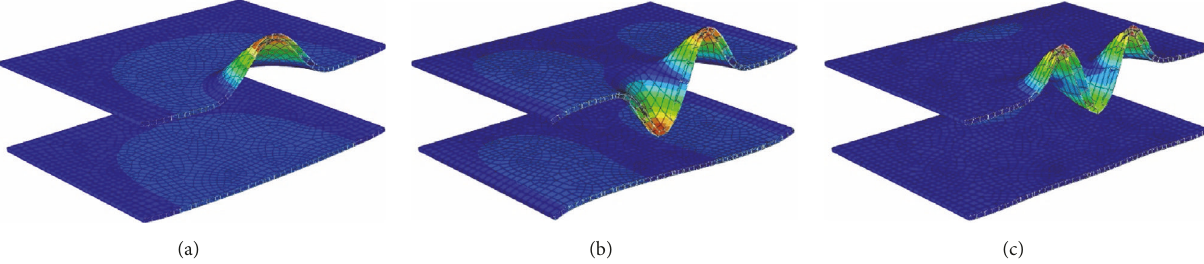
Figure 12: Local mode shapes in the debonded sandwich plate: (a) (1, 1) ; (b) (1, 2) ; and (c) (1,3) .